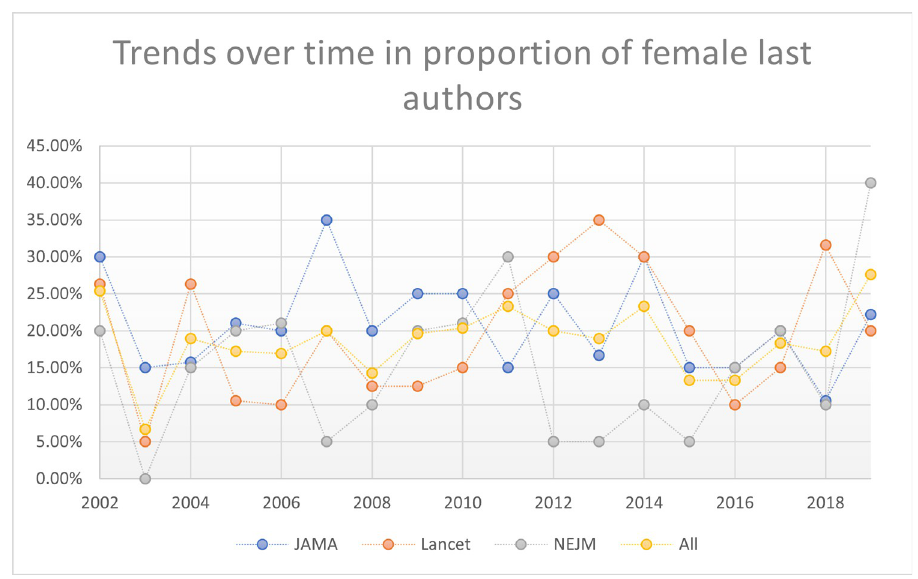
Fig 4. Trends over time in proportion of last authors by